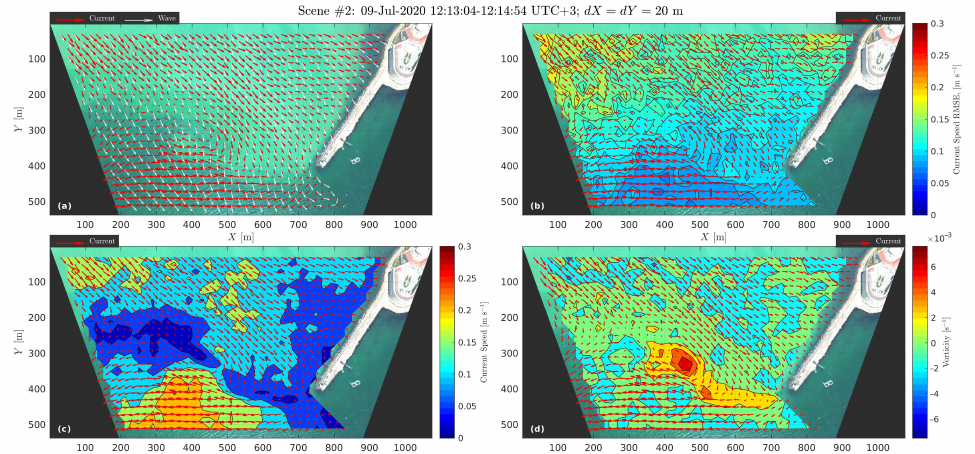
Figure 4. Scene #2: ( a ) sea surface current (SSC) and wave quiver maps; ( b ) SSC root-mean-square error (RMSE); ( c ) SSC speed; and ( d ) SSC